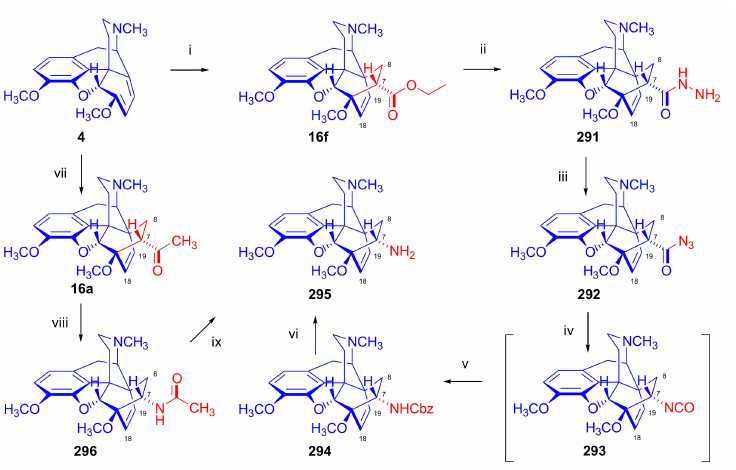
Figure 79. Synthesis of 7 α -amino-6,14- endo -ethenotetrahydorothebaine. Reagents and conditions : (i): ethyl acrylate, reflux, 6 h; (ii): hydrazine hydrate, 2-ethoxyethanol, reflux, 8 h; (iii), sodium nitrite, 15% hydrochloric acid; (iv) and (v): benzyl alcohol, reflux, 10 min; (vi): HCl in EtOH, reflux, 1 h; (vii): methyl vinyl ketone, reflux, 1 h; (viii): sodium azide, 72% w/w perchloric acid, 65–75 ◦ C, 5 h; and (ix): 5M HCl, steam-bath, 4